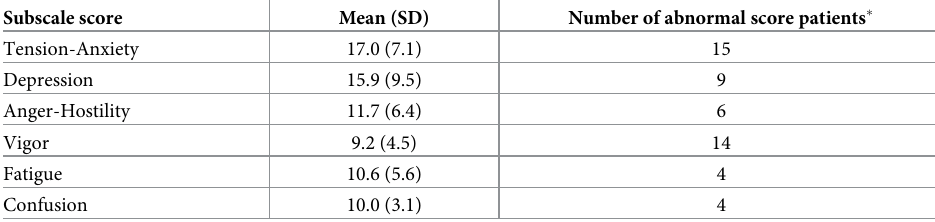
Table 3. Profile of Mood States (POMS) subscale scores in the study. Subscale score Mean (SD) Number of abnormal score patients (cid:3) Tension-Anxiety 17.0 (7.1) Depression